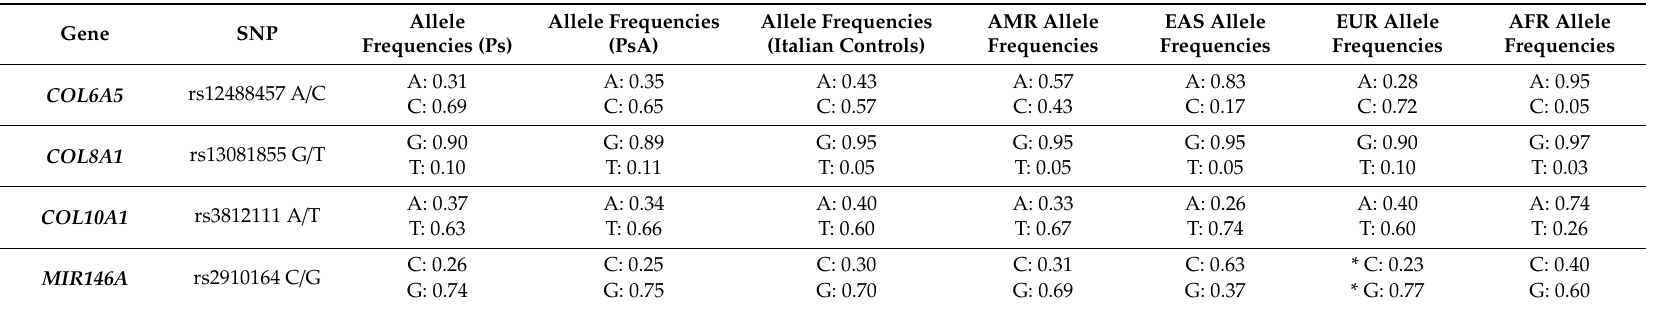
Table 1. Allele frequencies of the SNPs of interest in Ps, PsA, Italian healthy control cohorts and across di ff erent populations. The AMR, EAS, EUR and AFR allele frequencies for rs12488457, rs13081855 and rs3812111 have been extracted from 1000 Genomes, whereas the rs2910164 frequencies are referred to GnomAD. * These frequencies refer to the Non-Finnish European (NFE) Population. AMR: American; EAS: East Asian; EUR: European; AFR: